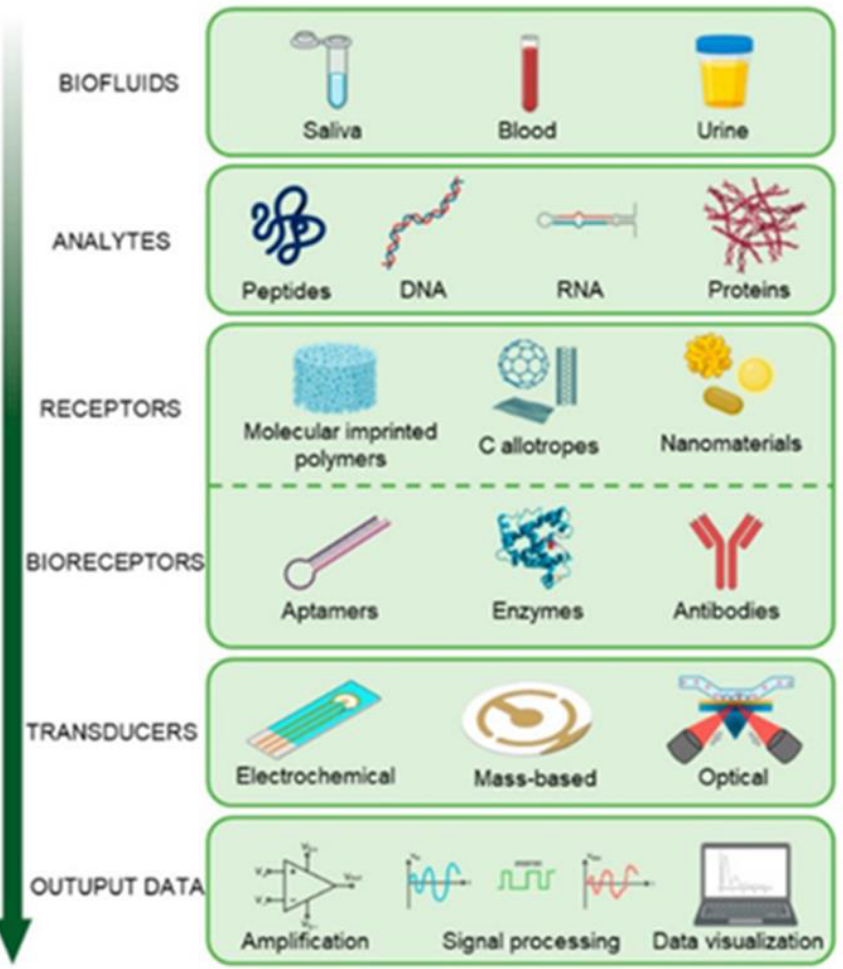
Figure 2. Biosensors’ operating and constituents. Biosensor systems are composed of three basic Figure 2. Biosensor s’ operating and constituents. Biosensor systems are composed of three basic components. These are ‘biomolecule/bioagent’ with a mechanism of selective detection, ‘converter’ components. These are ‘ biomolecule/bioagent ’ with a mechanism of selective detection, ‘ converter ’ and ‘electronic’ parts capable of transforming the physical-chemical signals resulting from the interaction of this bioagent with the substance under investigation into an electronic